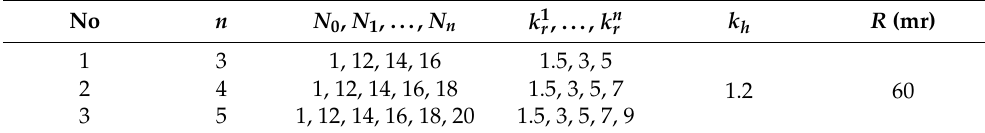
Table 3. Parameter combination of different sampling layers.